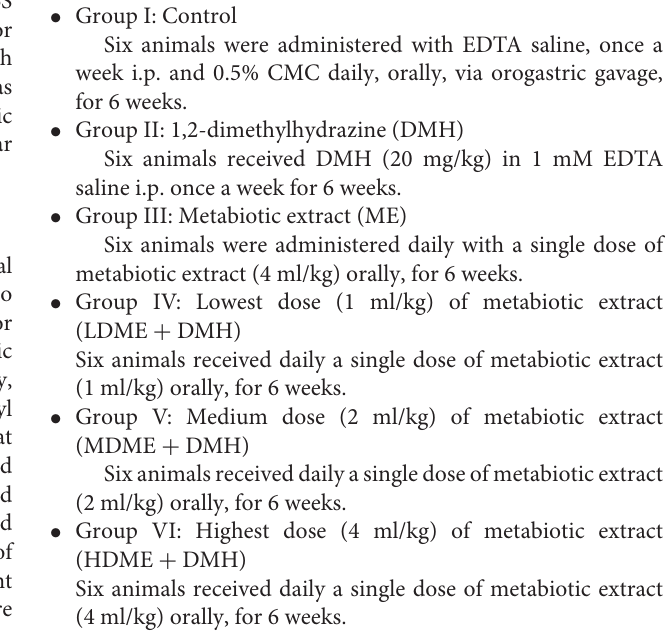
Frontiers in Oncology |